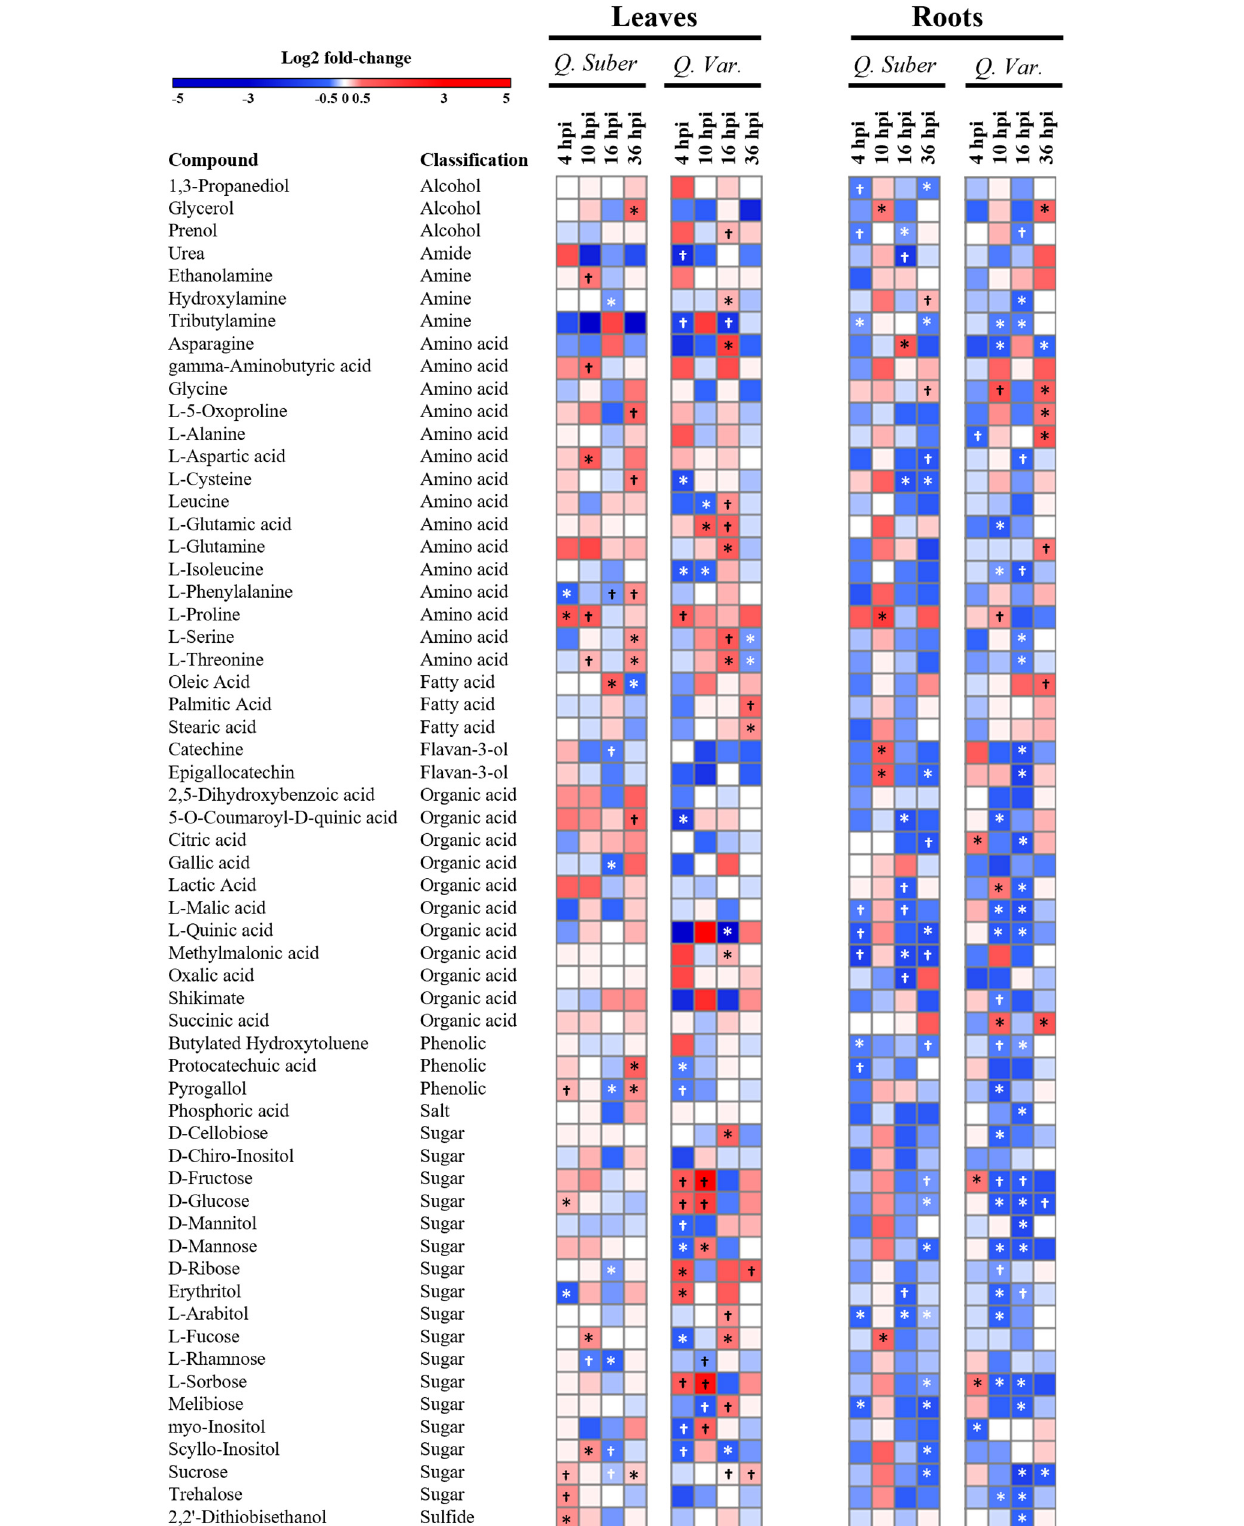
Frontiers in Microbiology |